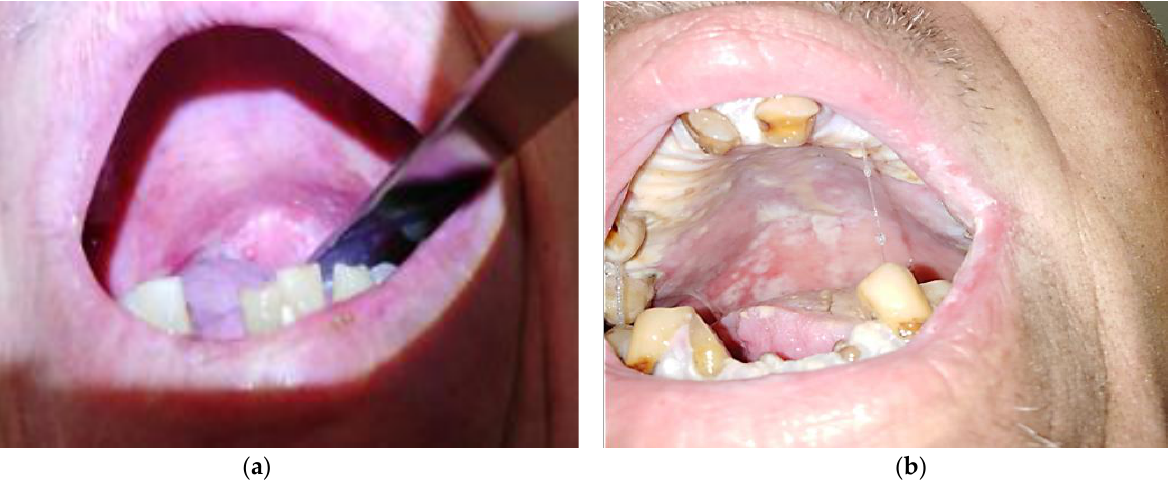
Figure 2. Oral mucositis in patients with head and neck cancer treated with concurrent radiochemotherapy. ( a ) Erythema, ( b ) ulcerations covered by fibrinous pseudomembranes and secondary fungal colonization (authors’ collection May 2022).